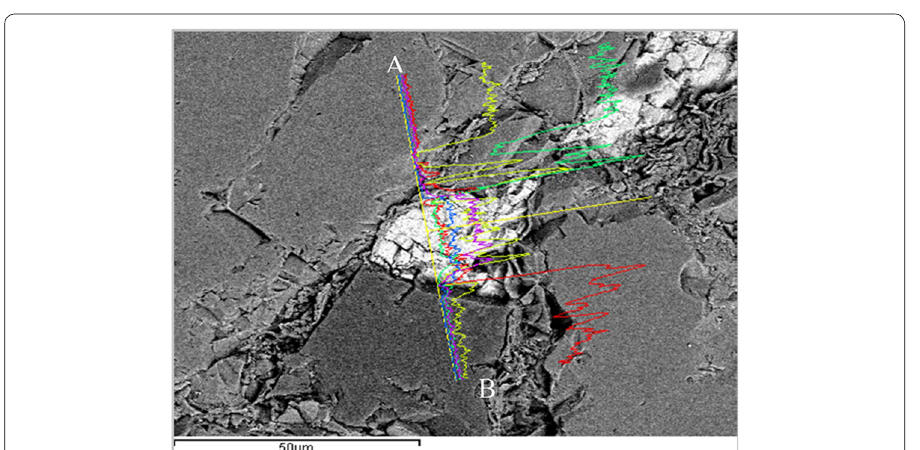
Fig. 16 Position and results (for details see Fig. 17) of a line scan over a barite crystal to analyze its chemical